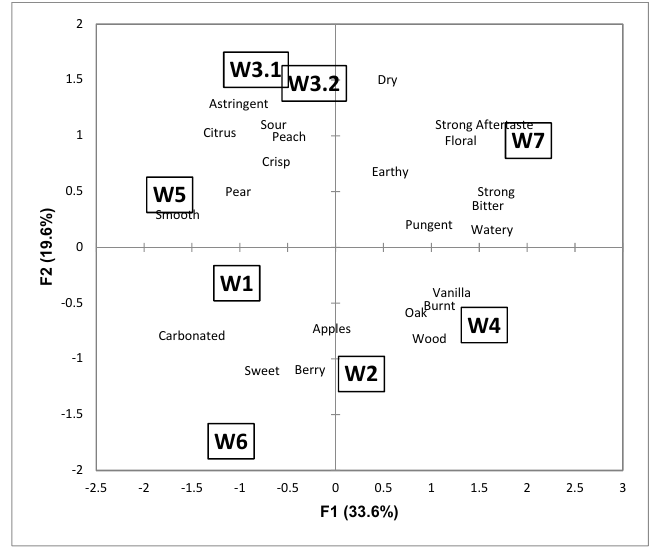
Figure 1. Representations of the eight sparkling wine samples (one duplicate sample) and the terms used to describe the samples at the first two dimensions of the multiple factor analysis of the data from the projective mapping task and ultra-flash profile.